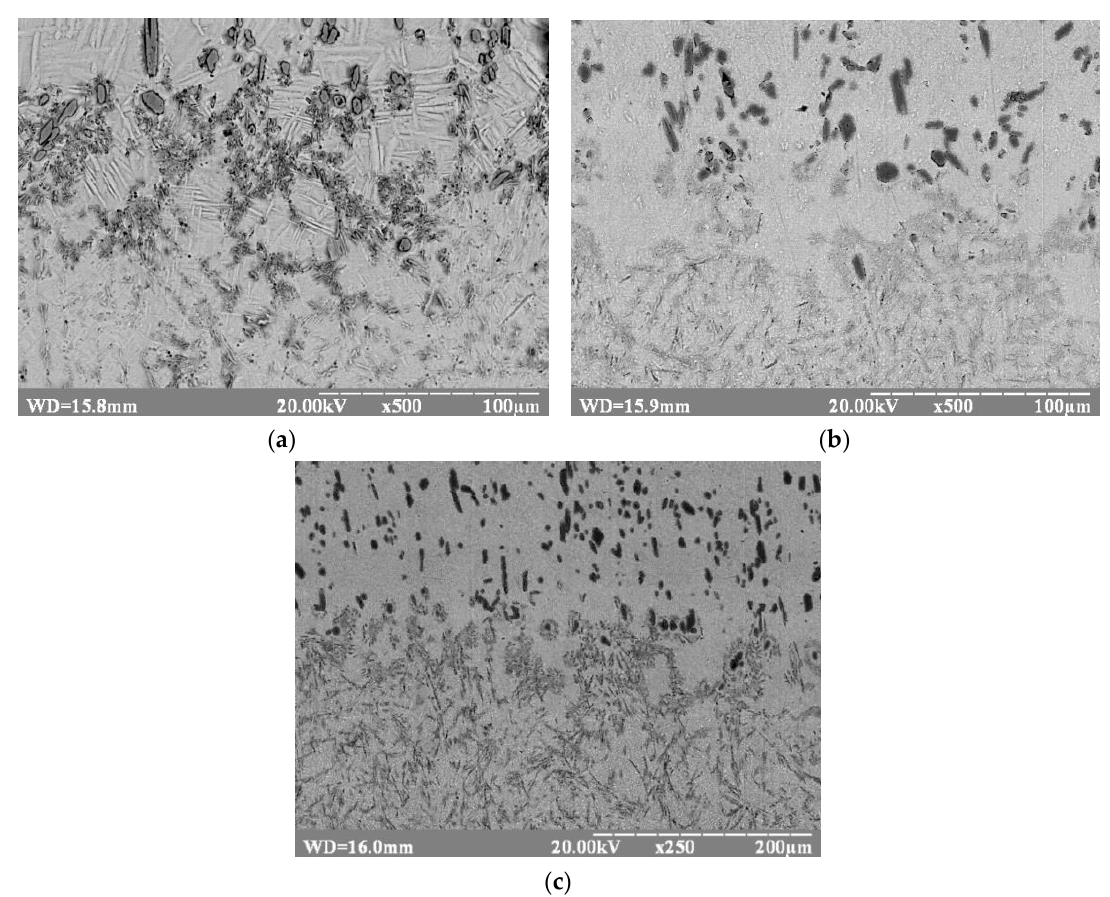
Figure 12. Microstructures of (Ti-TiB)–T110 welded joint material in Ti-TiB—welded seam zone: ( a ) number 6 series sample; ( b ) number 7 series sample; ( c ) number 8 series sample.